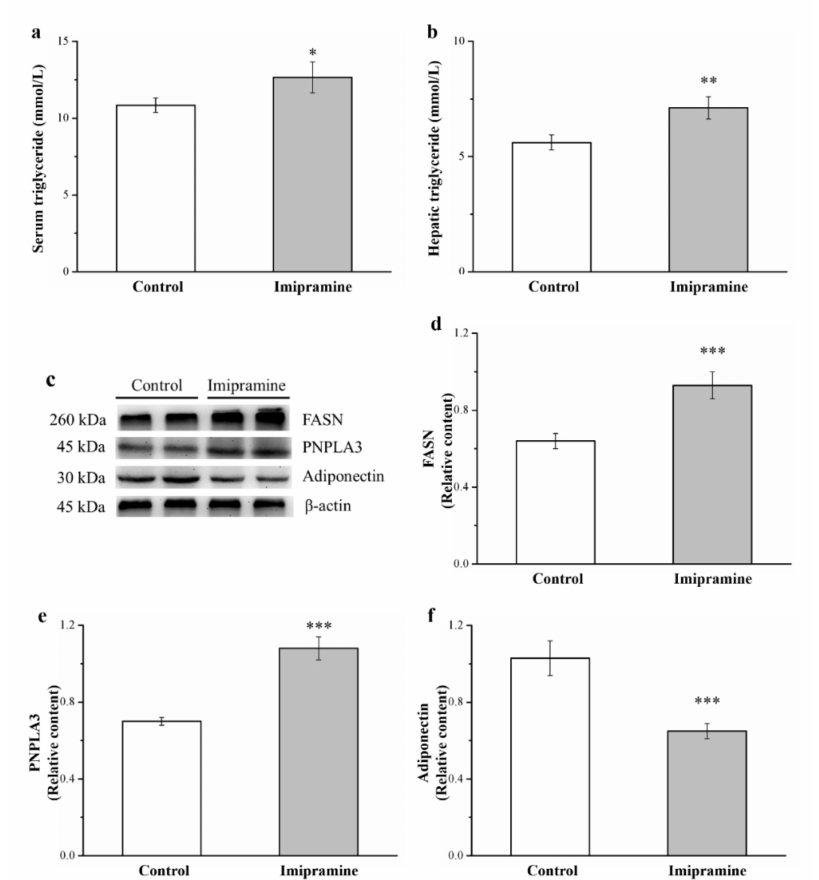
Figure 5. Effects of imipramine on ( a ) serum triglycerides and ( b ) hepatic triglycerides. ( c ) A representative image showing blots of liver extracts. The hepatic expression levels of ( d ) fatty acid synthase (FASN), ( e ) patatin-like phospholipid domain containing protein 3 (PNPLA3), and ( f ) adiponectin were measured. Data are in the form of mean ± standard deviation ( n = 8). * p < 0.05; ** p < 0.01; *** p <